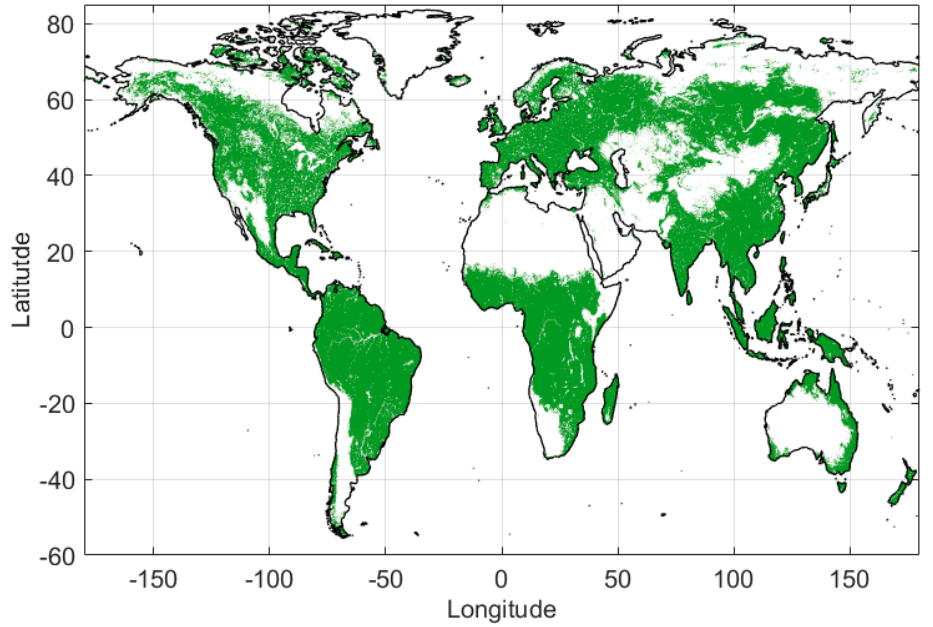
Figure 6. Retrieved mask of valid (dominant vegetation scattering) RVI-values (green) and excluded regions where soil scattering is dominant (white) at L-band.